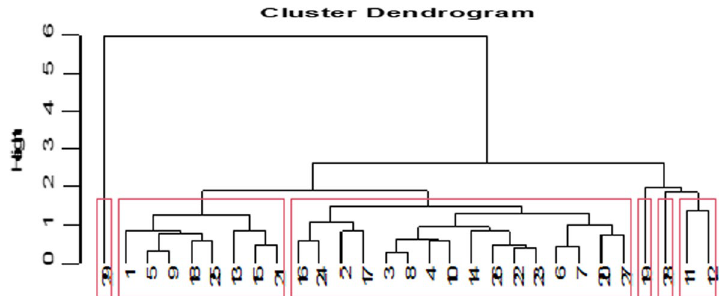
Fig. 3 Cluster dendrogram with spatiotemporal correlation in Stage 2. Note The numbers 1, 3, 12, 14, 16, and 23, 26 denote stock indices in developed markets; the remaining numbers denote indices in developing